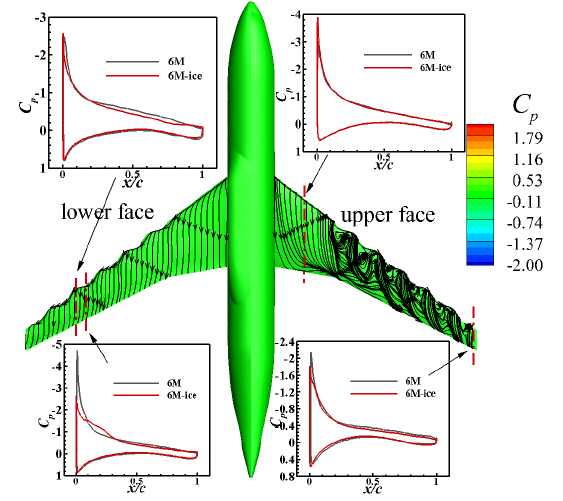
Figure 13. Flow field changes of 6M before and after ice